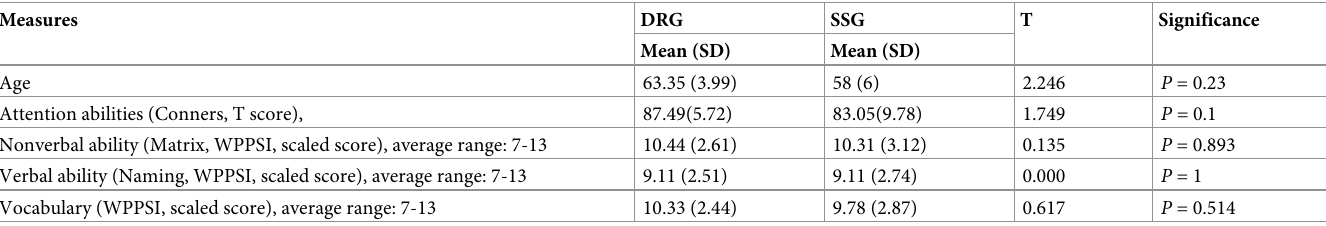
Table 1. Differences between the dialogic reading and screen stories intervention groups before intervention using independent-samples t tests.